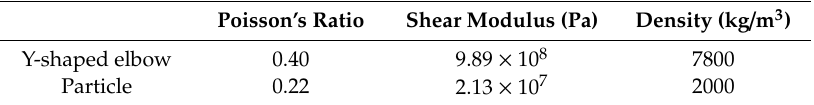
Table 5. Material properties of elbow and particle.